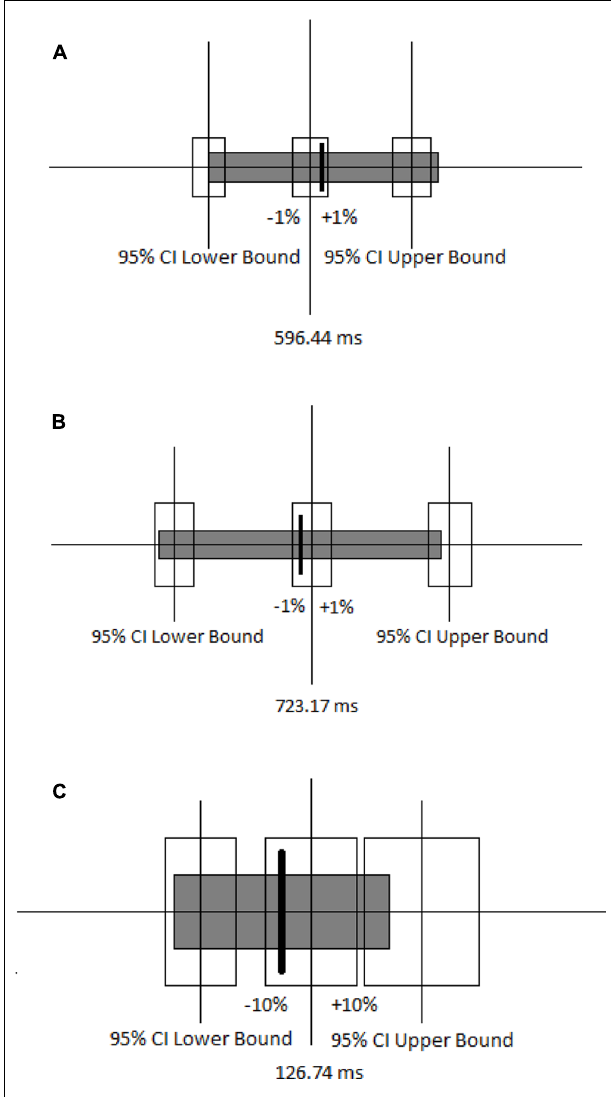
FIGURE 4 | (A) Ninety-five percent confidence interval around the mean RT for the congruent block when it came first is shown by the unfilled boxes. The thick line and gray box indicate the mean and 95% confidence interval for congruent trials when they came second. (B) Ninety-five percent confidence interval around the mean RT for the incongruent block when it came first is shown by the unfilled boxes.The thick line and gray box indicate the mean and 95% confidence interval for incongruent trials when they came second. (C) Ninety-five percent confidence intervals around the mean RT for the differences between the congruent and incongruent blocks when the congruent block came first is shown by the unfilled boxes. The thick line and gray box indicate the mean and 95% confidence interval for the difference between the congruent and incongruent blocks when the incongruent block came